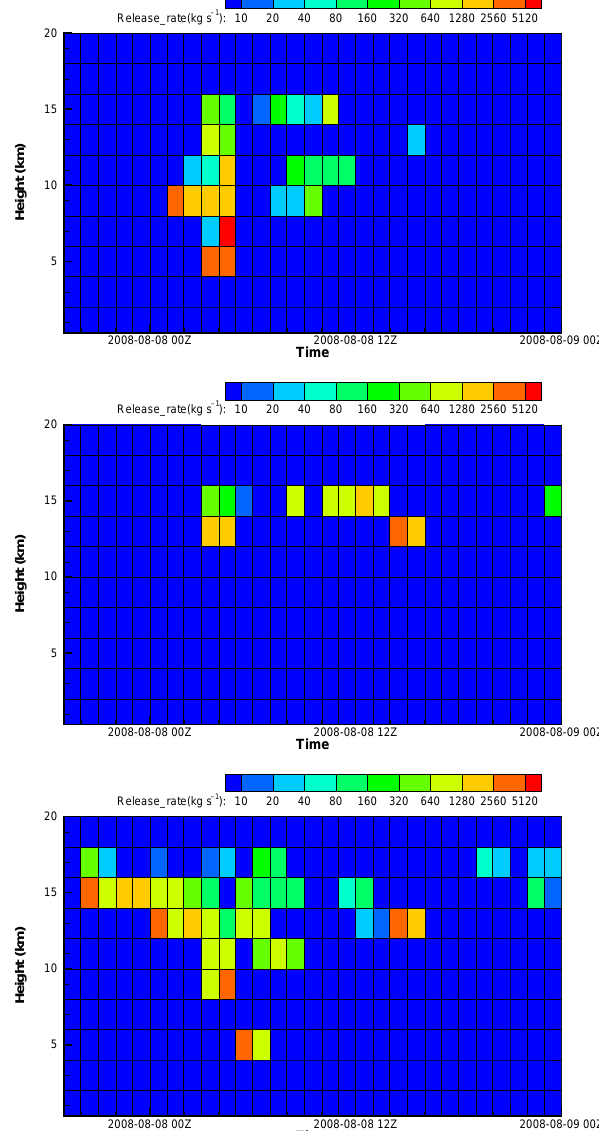
Figure 4. Volcanic ash release estimates with different options in the model mass loading calculation: (top) integrating from the sur- face to the cloud top (same as Fig. 3, top), (center) calculated for a single layer where the cloud top height resides, and (bottom) inte- grating over three layers centered at the cloud top